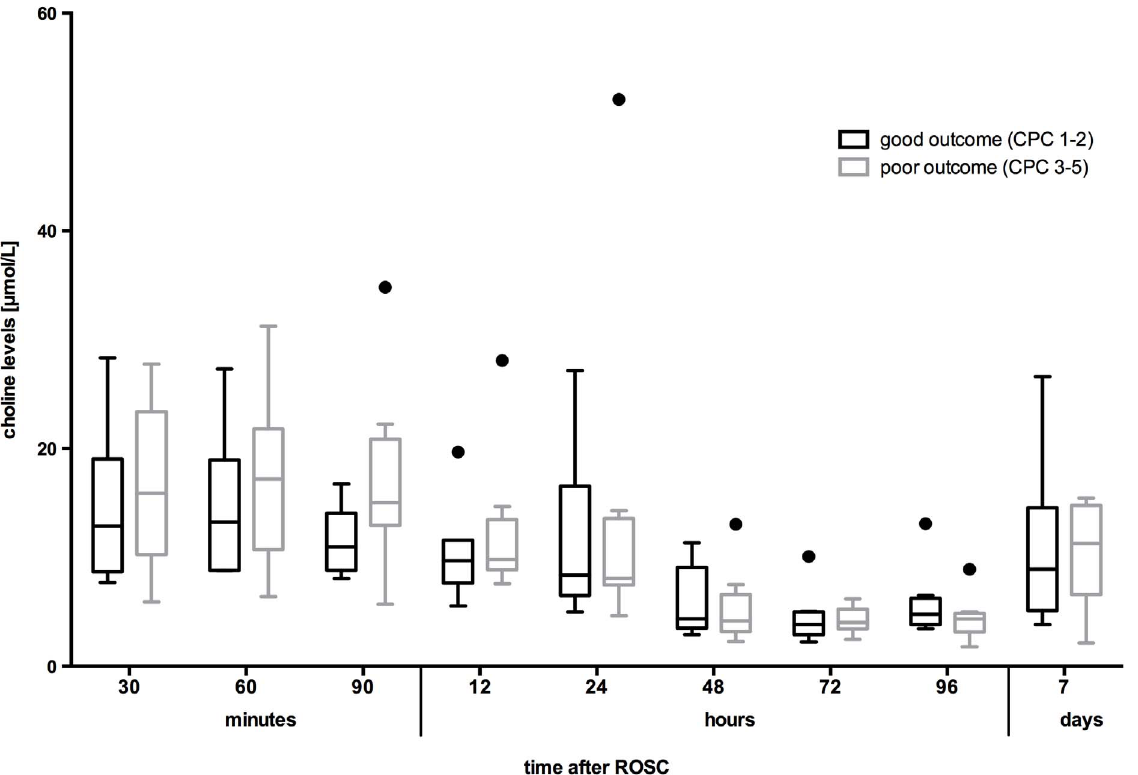
Figure 3. Plasma free choline concentration throughout the study in both subgroups.